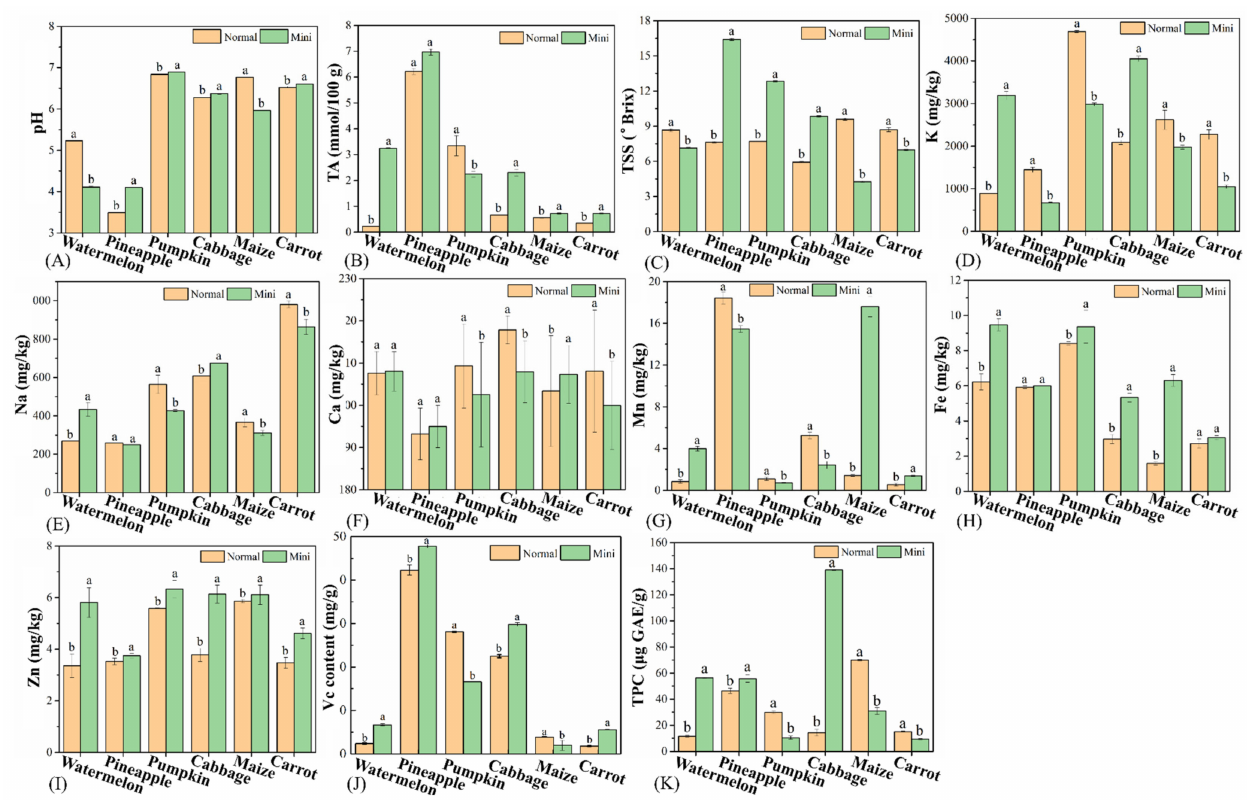
Figure 2. Physicochemical properties and nutrient contents of MFV and NFV. ( A ) pH; ( B ) TA; ( C ) TSS; ( D ) K; ( E ) Na; ( F ) Ca; ( G ) Mn; ( H ) Fe; ( I ) Zn; ( J ) Vc; ( K ) TPC. Values with different letters are significantly different ( p < 0.05) from each